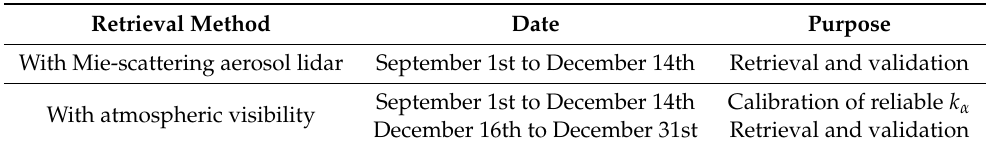
Table 3. Experimental arrangements of two retrieval